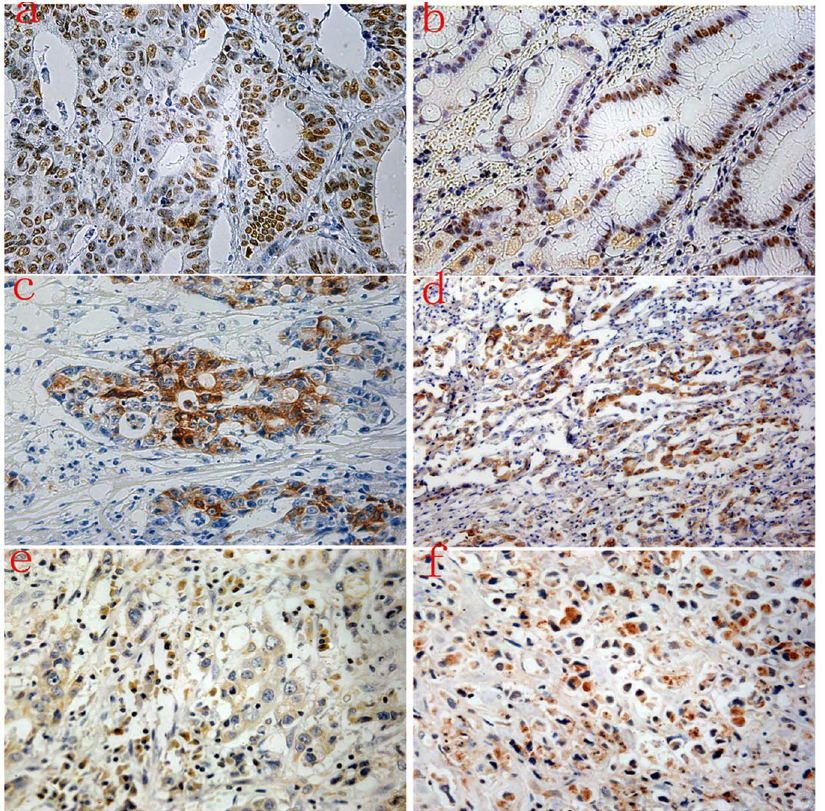
Figure 1. Immunohistochemical expression levels of NPM, TFF3 and TACC1 in gastric cancer. Strong staining of NPM was observed in the nucleolus, nucleus and cytoplasm of tumor epithelial cells (a, b). High expression of TFF3 (c and d) was predominantly observed in the cytoplasm of tumor epithelial cells. TACC1 was expressed in the cytoplasm of tumor epithelial cells (e and f). doi:10.1371/journal.pone.0082136.g001 PLOS ONE |